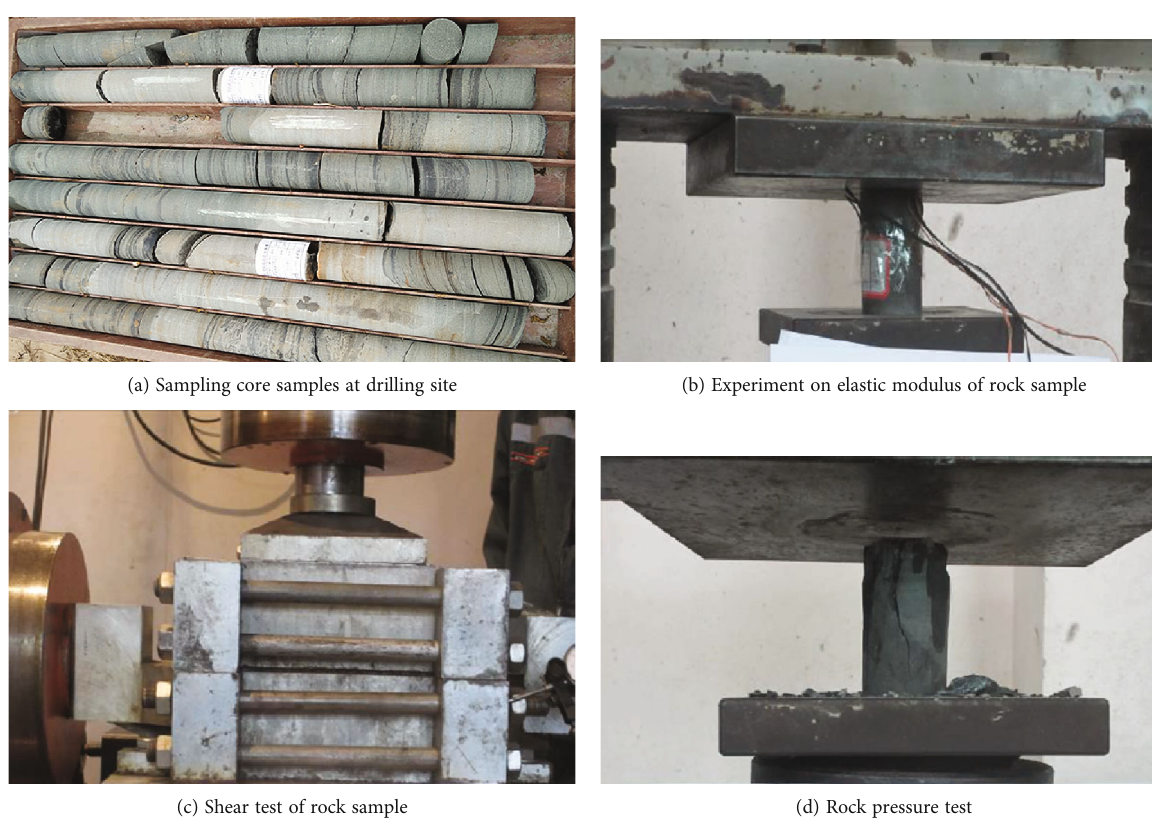
Figure 9: Field rock samples and physical and mechanical experiments. Table 3: Mechanical parameters of coal